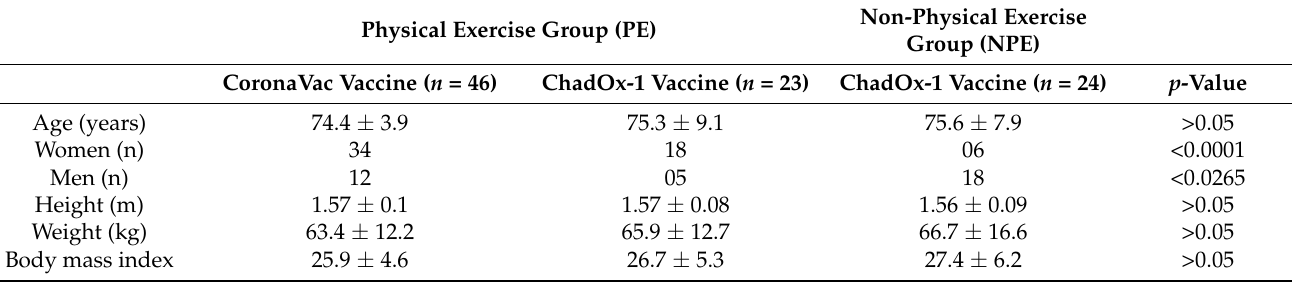
Table 1. Characterization of participants by the three intervention groups for biosocial and anthropo- metric data.